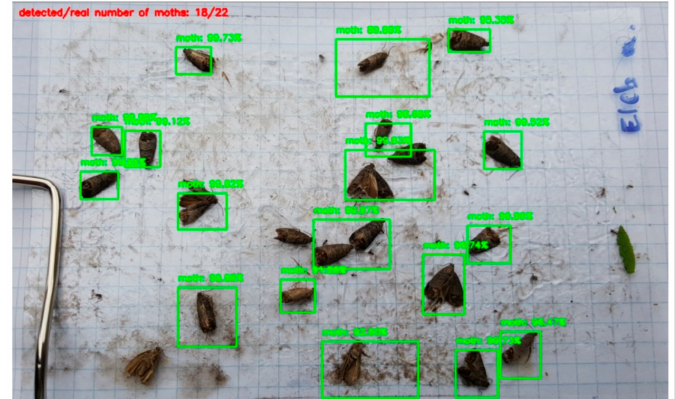
Figure 9. Detected moths with NMS.